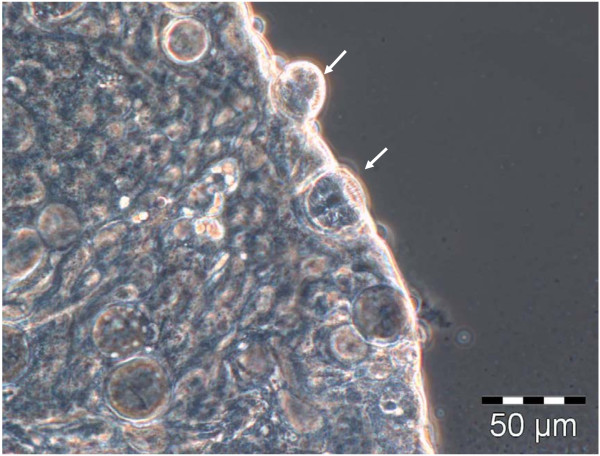
Oocysts on An. funestus midgut at 20 days post infected blood meal. The oocysts are at different stages of maturation, some containing immature sporozoites (white arrows) (phase contrast, 400 × magnification).